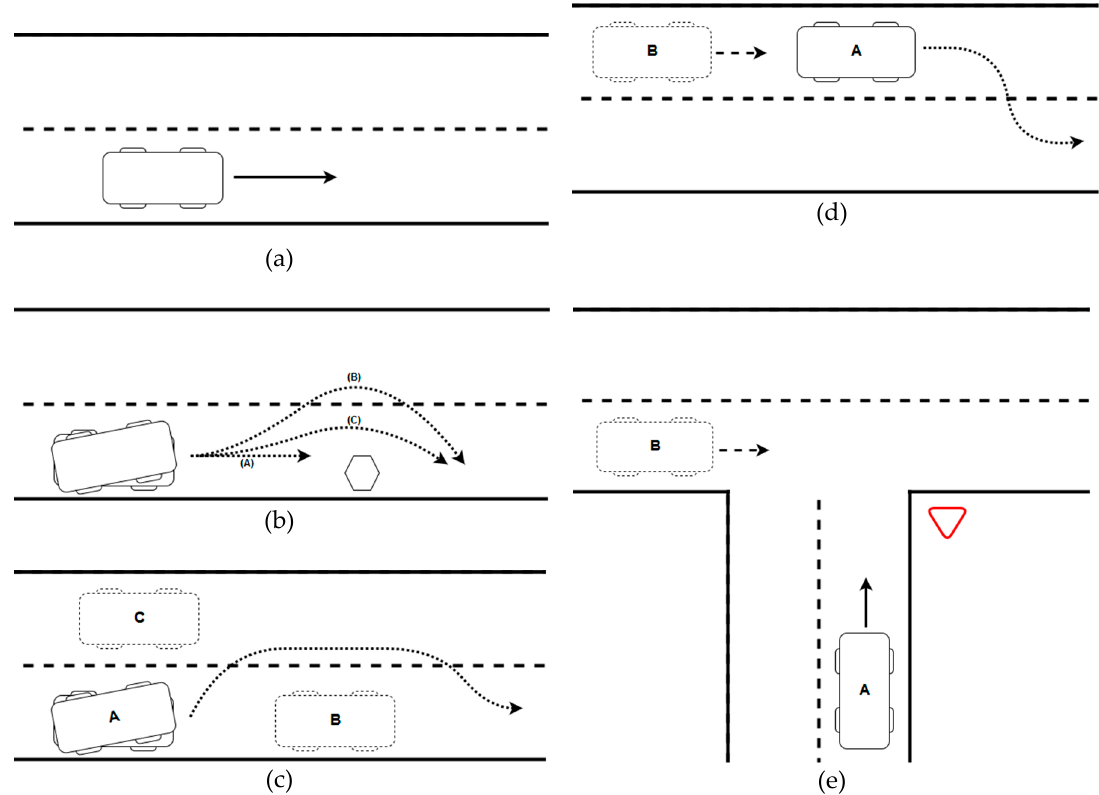
Figure 8. Simulated scenarios. ( a ) Lane maintenance; ( b ) obstacle in the lane; ( c ) overtaking maneuver; ( d ) overtaking facilitating; ( e ) crossing approach.